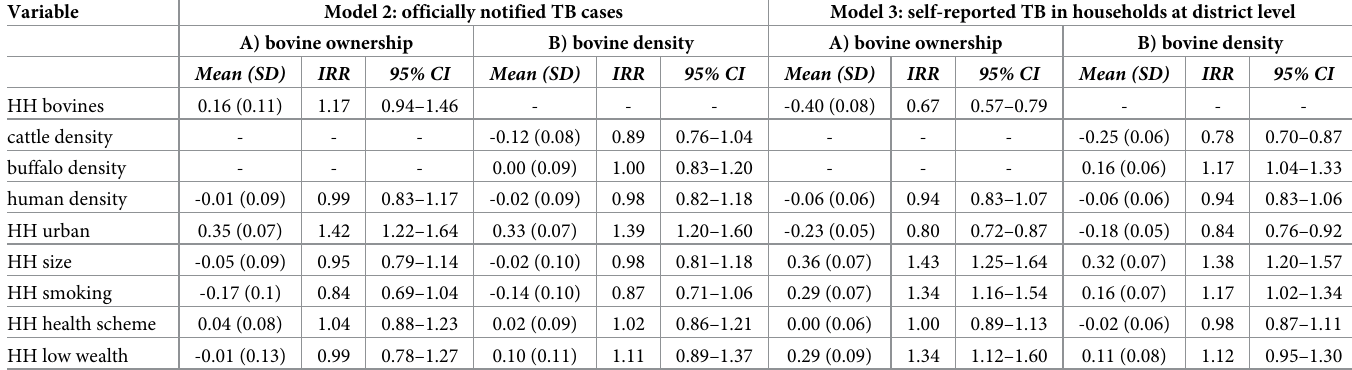
Table 4. Posterior estimates of mean fixed effects, standard deviation (SD), incidence rate ratio (IRR) and 95% credible interval (CI) from Bayesian inference (INLA) of officially notified tuberculosis cases in humans (model 2) and self-reported tuberculosis in households (model 3) at district level in India. For each model, one out of two bovine exposure measures were assessed: A) bovine ownership in households or B) cattle and buffalo